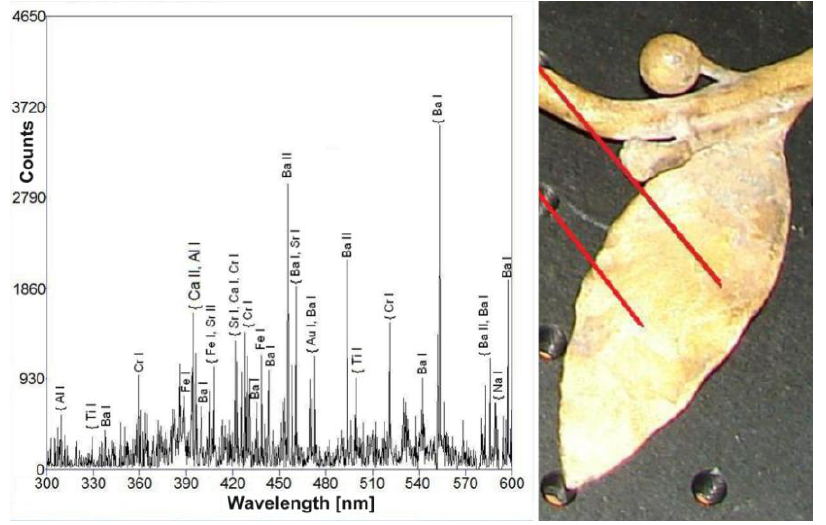
Figuree 13. LIBS spectrum of the laurel leaf surface. Right hand side—photograph with the measurement points